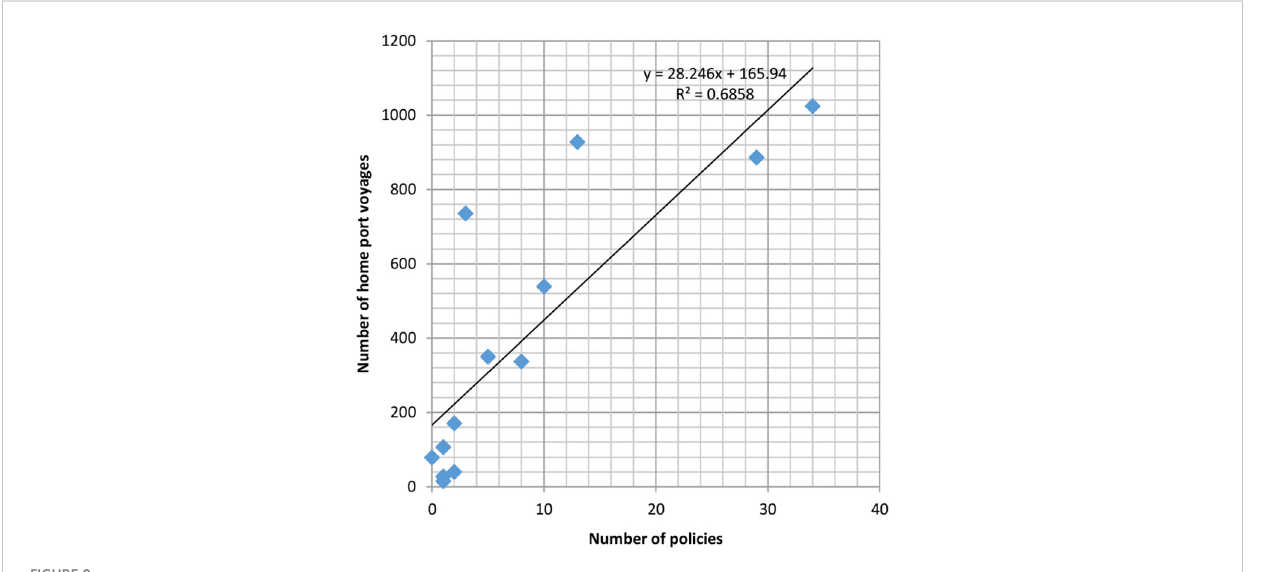
FIGURE 9 Linear relationship between cruise policies and home port